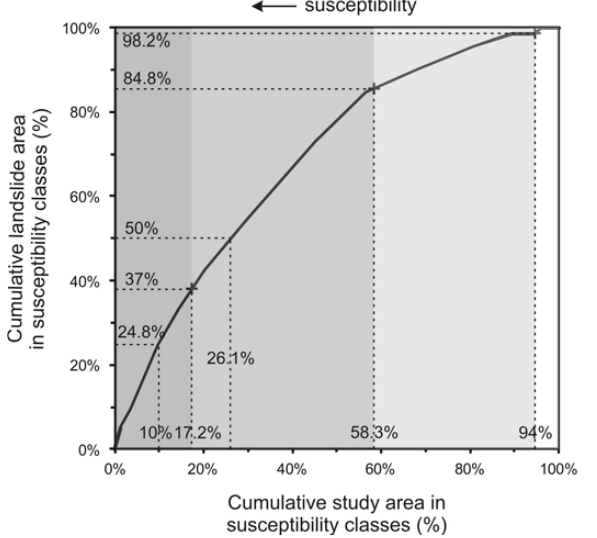
Fig. 6. Analysis of the fitting degree of landslide susceptibility